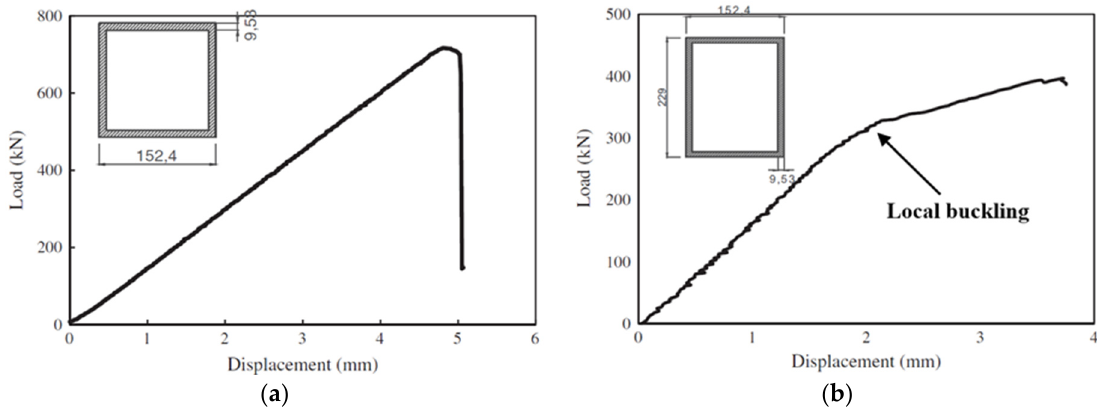
Figure 14. Load-displacement curves of hollow ( a ) square and ( b ) rectangular box PFRP profiles under axial compression [17].